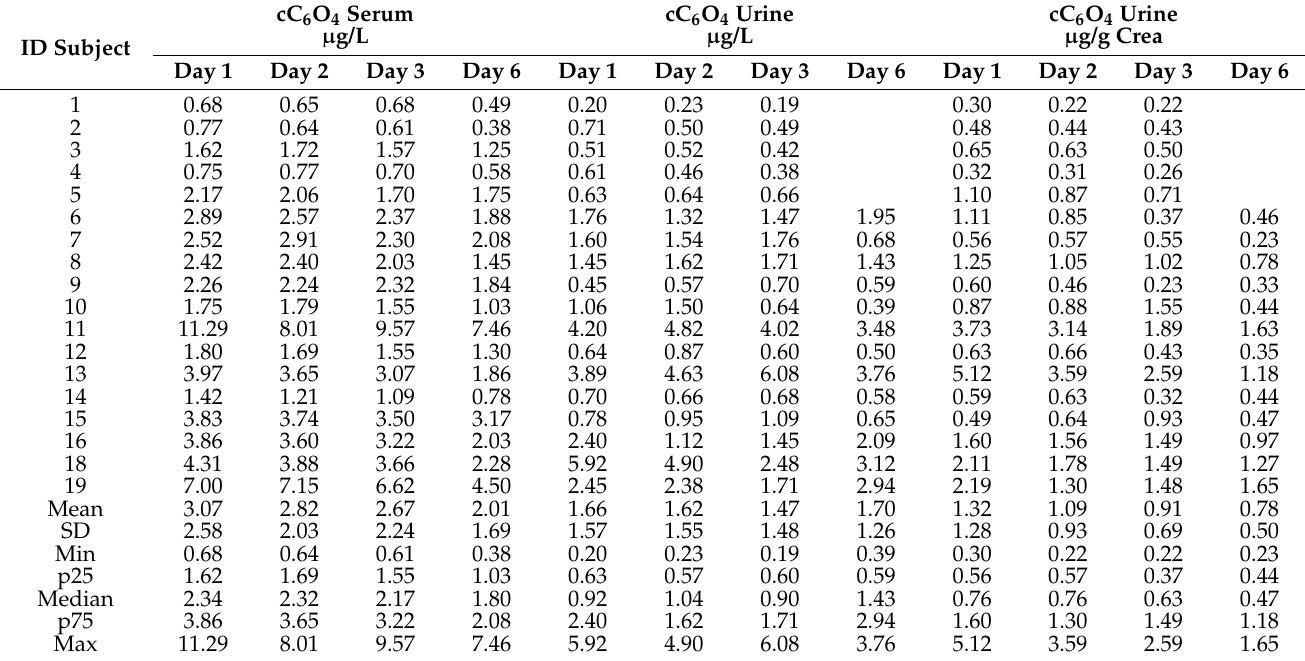
Table 2. Concentration of cC 6 O 4 in serum and urine for each sampling day.